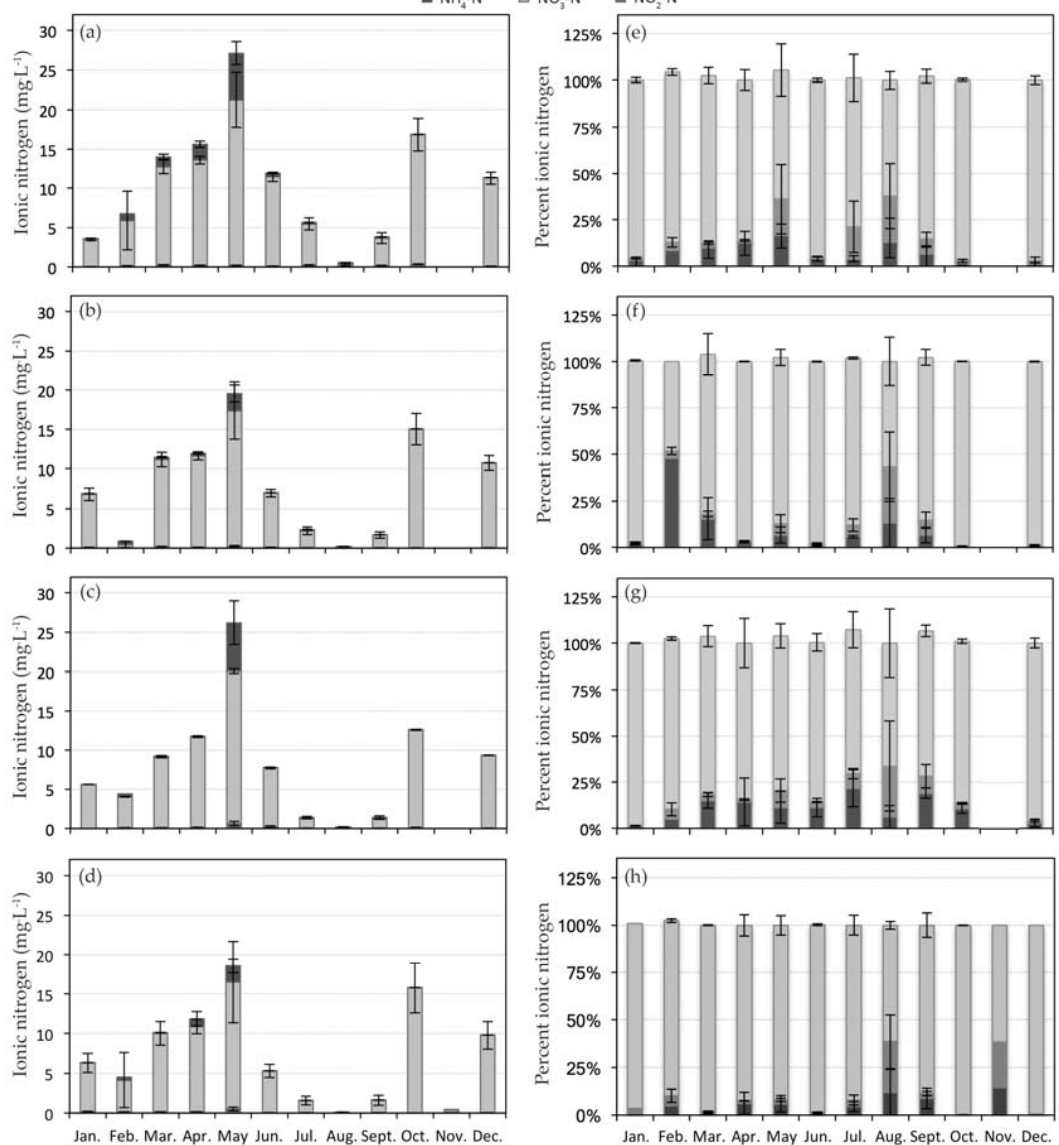
Figure 3. The concentration and percent of ionic nitrogen (nitrite (NO 2 -N), nitrate (NO 3 -N) and ammonium (NH 4+ -N)) detected in sites within Constructed Wetland 1: ( a , e ) Site 2 (outflow from Stage 1); ( b , f ) Site 3 (outflow from Stage 2); ( c , g ) Site 4 (discharge channel); and ( d , h ) Site 5 (stilling ponds). Error bars represent the standard error ( ± ) of the mean value.